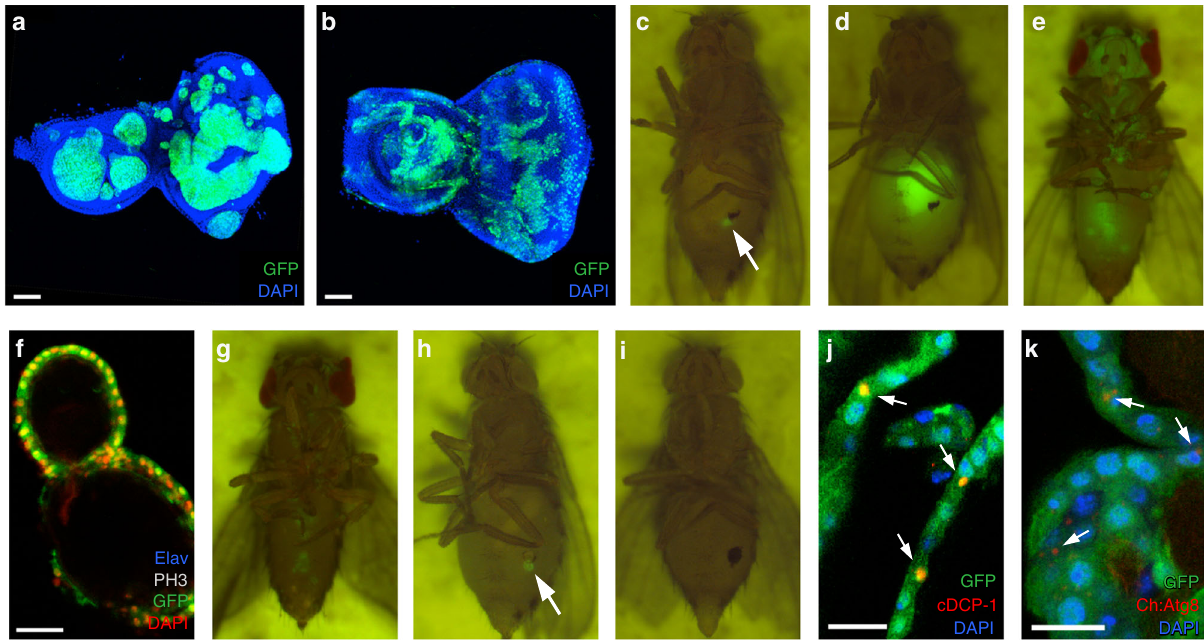
Fig. 1 Conversion of tumorigenic ph 505 cells into nontumorigenic metamorphed cells. a , b Confocal images of the eye-antennal discs at wandering third instar containing overgrown ph 505 tumour ( a ) or wild-type clones ( b ). Scale bars are 50 μ m. c , d Transplantation of a small piece of the eye disc containing GFP-labelled ph 505 cells (arrow) into a wild-type adult host. Pictures of the same host were taken at 1 day ( c ) or at 2 weeks ( d ) after transplantation, showing tumour formation in the abdomen ( d ). e GFP-labelled ph 505 cells are present throughout the body in the adults at 1 day after eclosion. f Confocal image showing the ph 505 cells form a single layer of cells in a grape-like structure. The cells do not proliferate (negative for PH3) and do not differentiate into neurons (negative for Elav). Scale bar is 20 μ m. g The GFP-positive cells disappeared after 4 days in the same fl y as e . h , i Transplantation of metamorphed ph 505 cells into a new wild-type adult host (arrow). Pictures of the same host were taken immediately after transplantation ( h ) or at 1 week after transplantation ( i ), showing the transplanted cells do not grow but disappear. j , k Confocal images of metamorphed ph 505 cells in the grape-like structures, showing a subset of cells expressing the apoptosis cell marker cDCP-1 ( j , arrows) or the autophagy cell marker Ch:Atg8 ( k , arrows). Scale bars are 20 μ m. Genotypes: a , e , f , g , j ph 505 FRT19A/tub-Gal80 FRT19A; + /ey- fl p act>STOP>Gal4 UAS-GFP ; b y w FRT19A/tub-Gal80 FRT19A; + /ey- fl